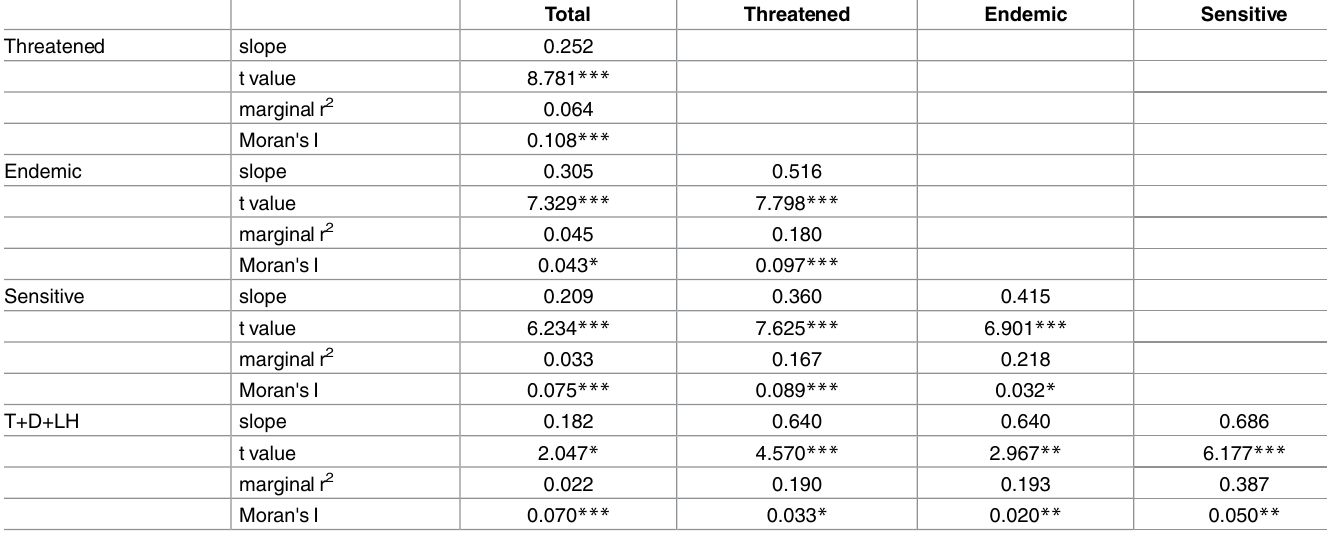
Table 3. Triangular matrixindicatingcorrelations of five diversitymeasurevalues